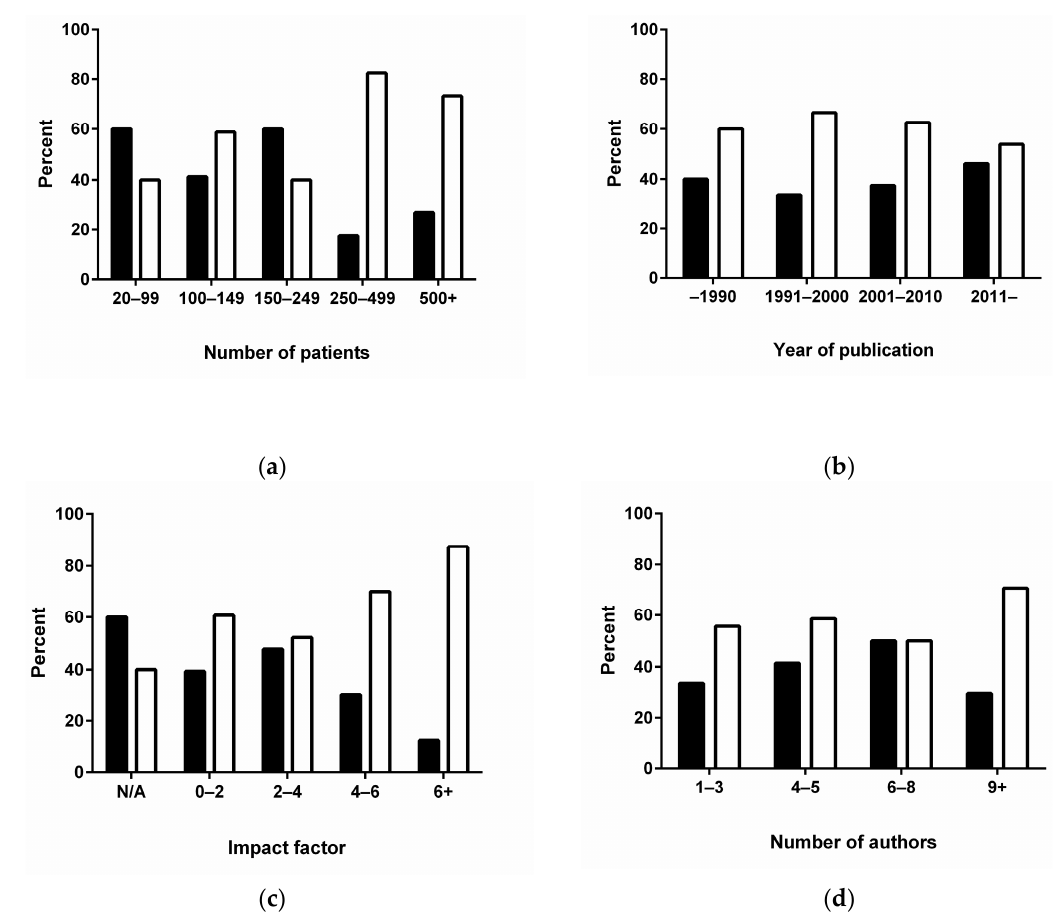
Figure 2. The association of variables with reporting of equivocal bone scans. There was a statistically significant trend with the number of patients in the trials with number of patients in each trial ( a ); but not with the year of publication ( b ); the impact factor of the journals ( c ) or the number of authors ( d ). Reporting of equivocal is shown with open bars, no equivocal scans with closed bars. Table 3. Study design and reporting of equivocal scan results.